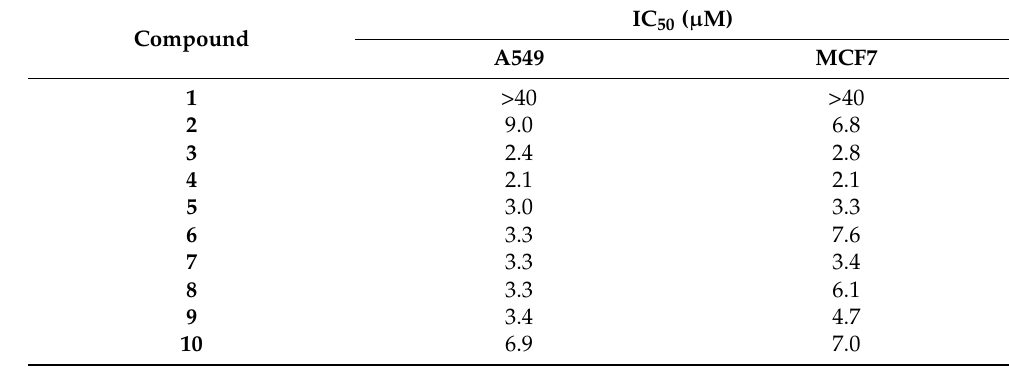
Figure 21. Arctigenin. Amino acid–arctigenin conjugates have reportedly been designed and synthesised to improve the solubility and bioavailability of arctigenin. Arctigenin–amino acid conjugates were synthesised using an amino acid–EDCI-DMAP ratio of 1:2:2:0.5 (Scheme 16). The reaction mixture was dissolved in acetonitrile and stirred for a period of one to two hours at 0 °C. The arginine–amino acid derivatives were created by deprotecting the crude prod- ucts with HCl gas [118,119].